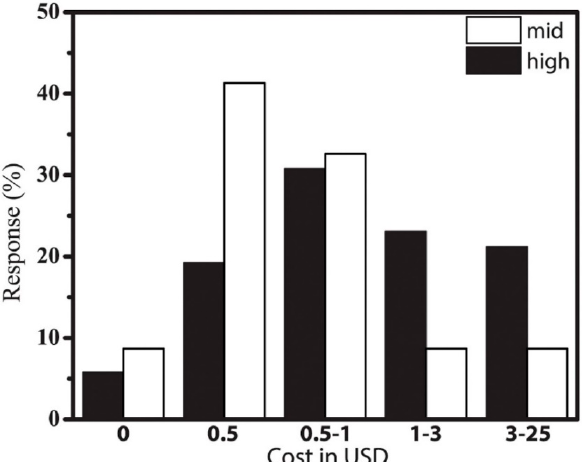
Figure 4. Survey of acceptable cost as given by the clinicians. Percentage of clinicians who named a specific price, depending on the level of the hospital. White: mid-tier; black: highest tier.